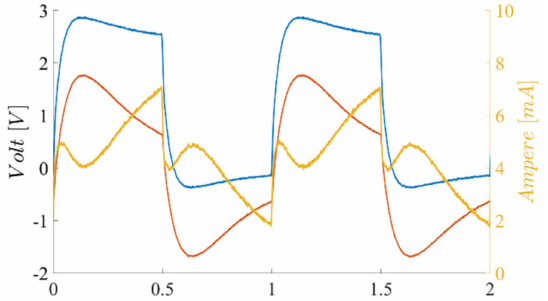
Figure 7. Coil excitation voltage (blue), coil voltage (red), and current